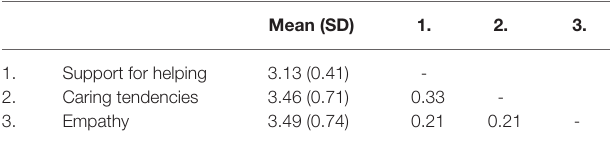
TABLE 1 | Means, SDs, and correlations for the variables included in the